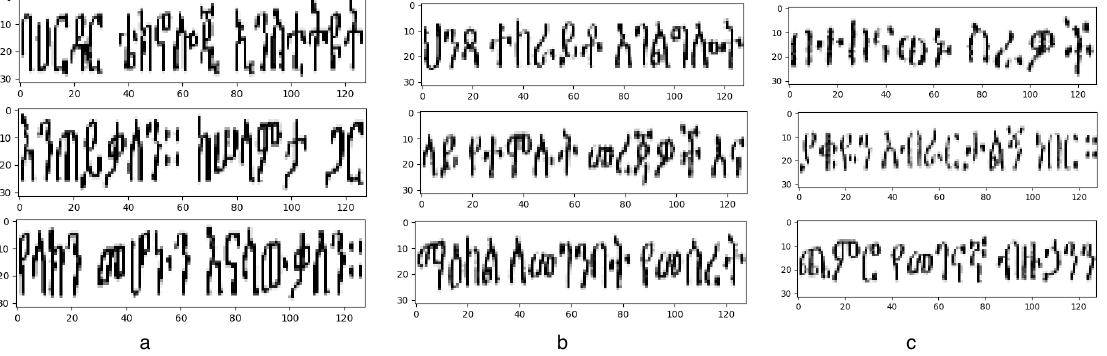
Figure 2. Sample Amharic text-line images that are normalized to a size of 32 by 128 pixels: ( a ) Printed text-line images written with the Power Geez font type. ( b ) Synthetically generated text-line images with the Visual Geez font type. ( c ) Synthetically generated text-line images with the Power Geez font type.